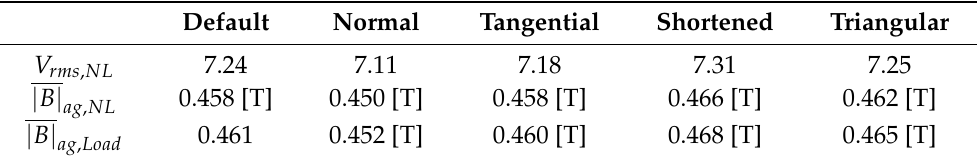
Table 5. Induced voltage and air gap flux density magnitude for the linear machine under